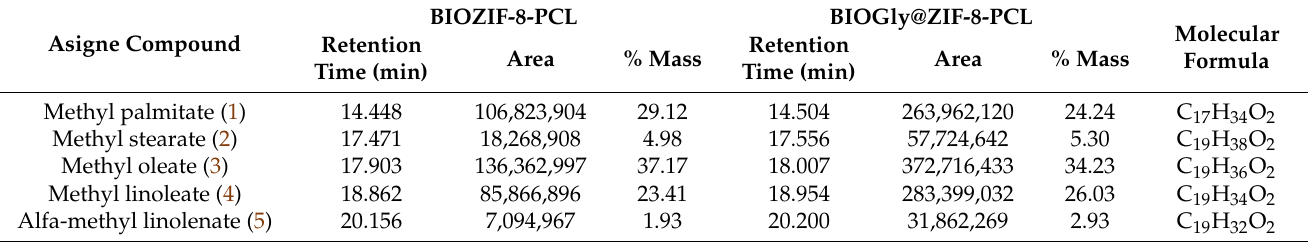
Table 2. CG-MS chemical composition of the comparative biodiesels and the synthesized